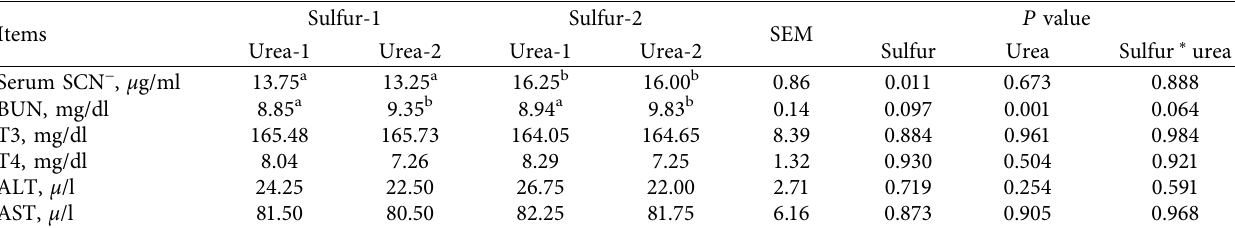
Table 4: Effect of sulfur and urea levels on thiocyanate (SCN − ), blood urea nitrogen (BUN), thyroid hormones, and liver enzymes in dairy cows.